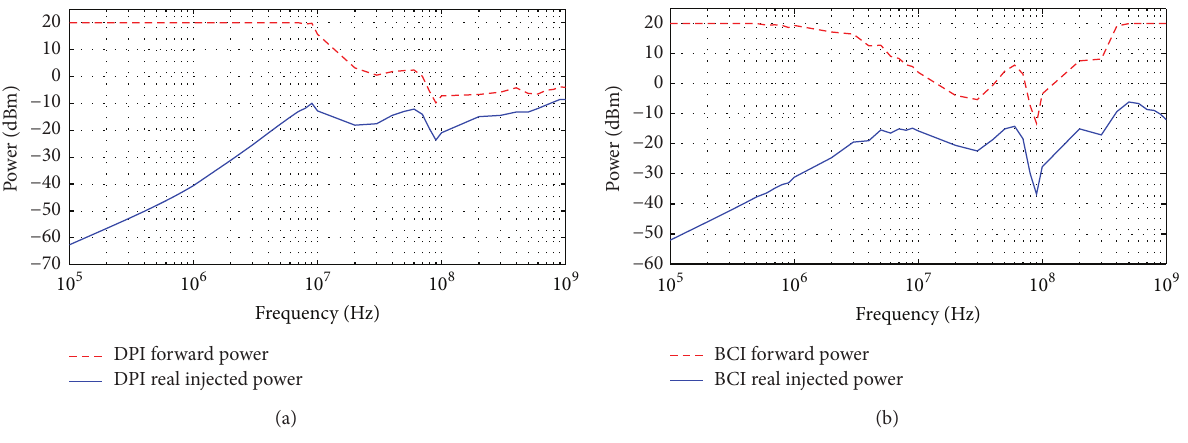
Figure 19: Measured forward power ( 𝑃 𝑠 ) and calculated real injected power ( 𝑃 𝐿 ) by the power transfer efficiency ( 𝐻 𝑝 ( dB ) ) with chip load. (a) DPI. (b)